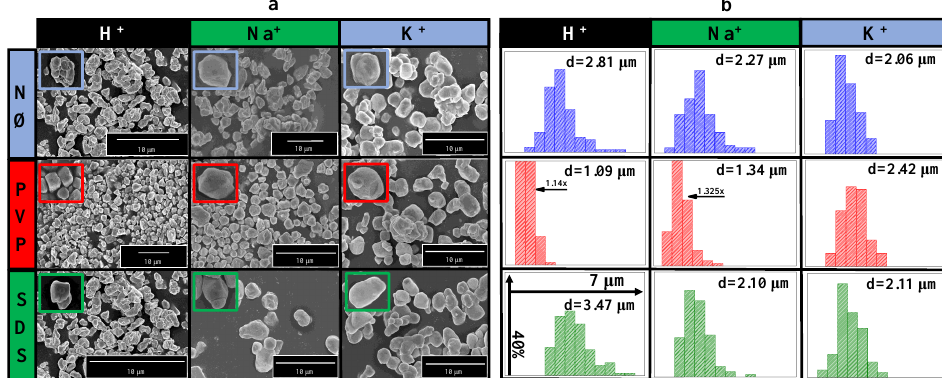
Figure 2. Morphological investigation of AgCl-based samples: ( a ) scanning electron microscopy (SEM) micrographs and ( b ) particle size distribution of AgCl photocatalysts prepared using different shape-tailoring agents (NØ; PVP and SDS), alkali metals (Na + , K + ) and H +